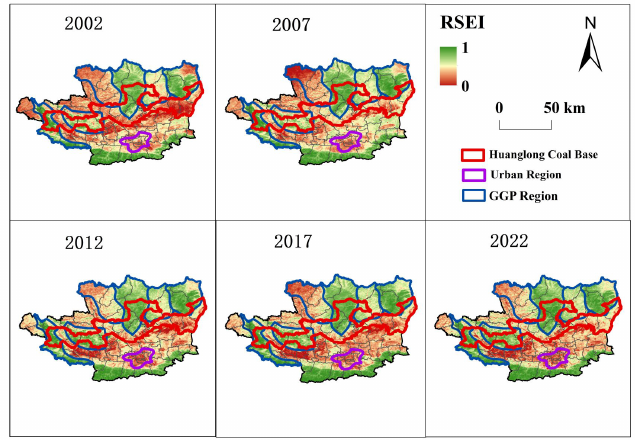
Figure 5. RSEI from June to October of 2002, 2007, 2012, 2017, and